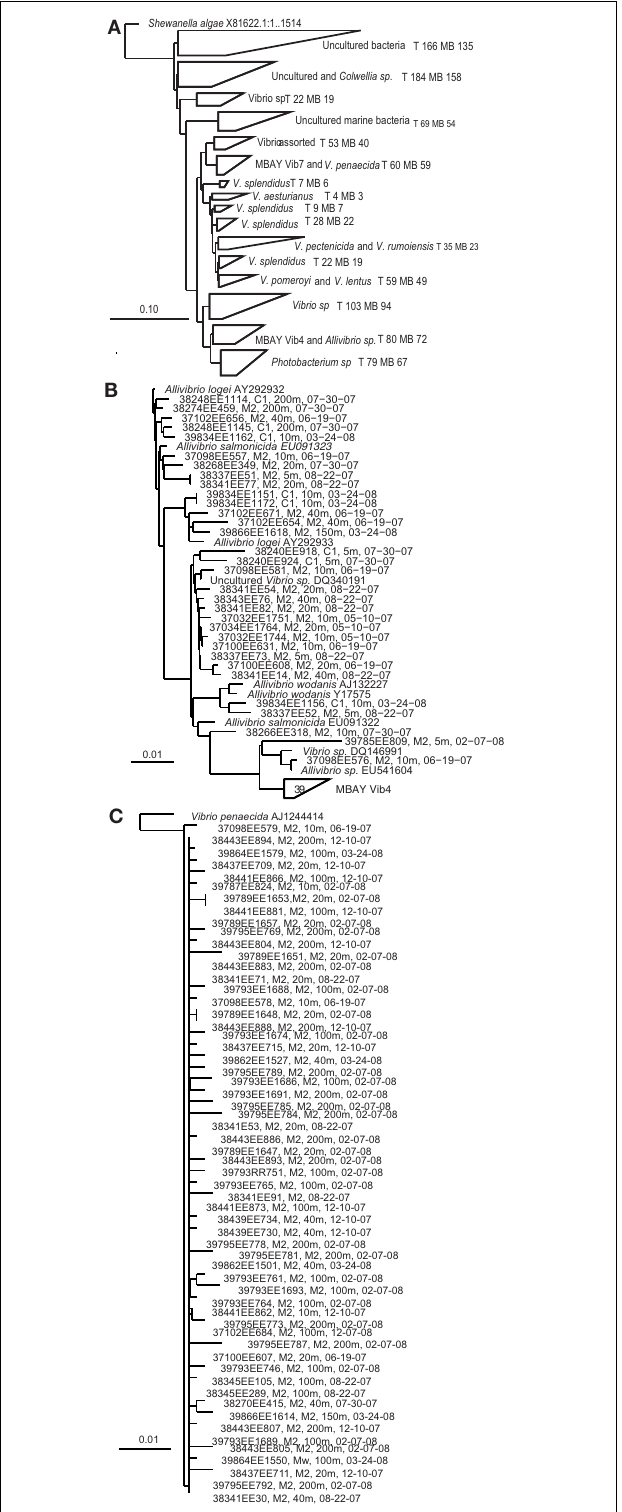
FIGURE 3 | Neighbor-joining phylogenetic trees of Vibro sequences from Monterey Bay at stations C1 and M2. Tree constructed in ARB from partial 16S rRNA sequences ( E. coli 27-680bp) using ARB neighbor-joining